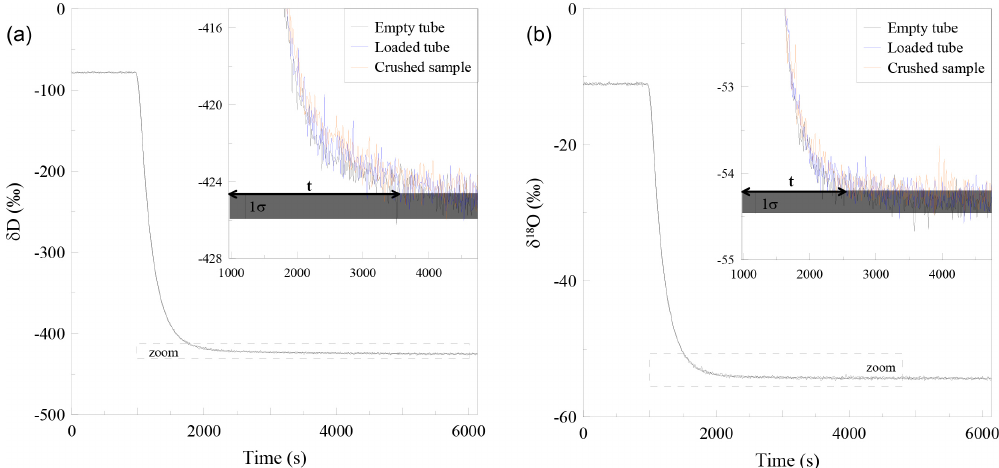
Figure 6. System response for switching from ST-08 to DOME-C standard water. No difference is noticeable for empty, loaded or crushed tube conditions.